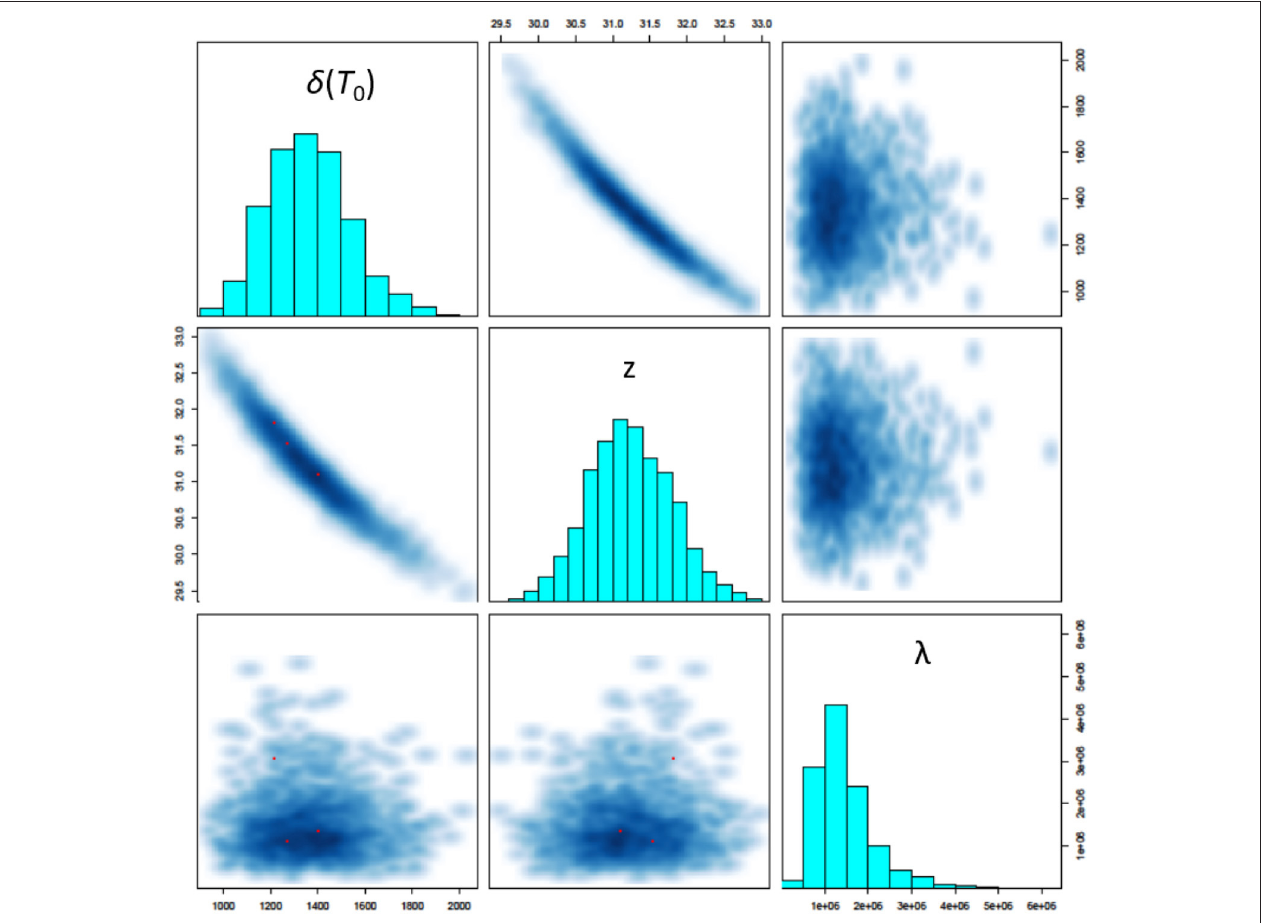
FIGURE 5 | Pairs plot showing simulated posterior marginal distributions of model parameters along the diagonal and pairwise joint distributions off-diagonal. The three most critical parameters to assessing survival in the model are shown here: the D -value at 150 ◦ C [ δ ( T 0 )], the z -value ( z ) and the mean number of microorganisms seeded onto a coupon ( λ